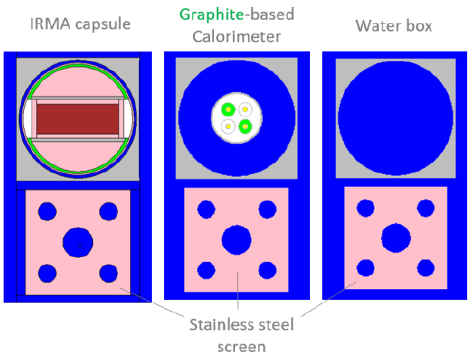
Fig. 10. TRIPOLI-4® modelling of the IRMA capsule and the graphite-based double differential dosimeter in the water reflector of the OSIRIS MTR.